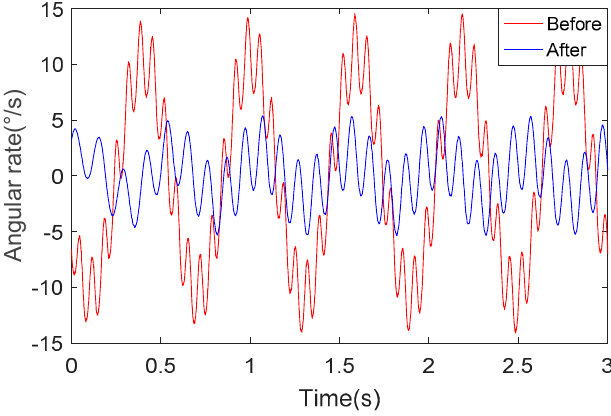
Figure 15. Angular rate in the direction of the roll axis.